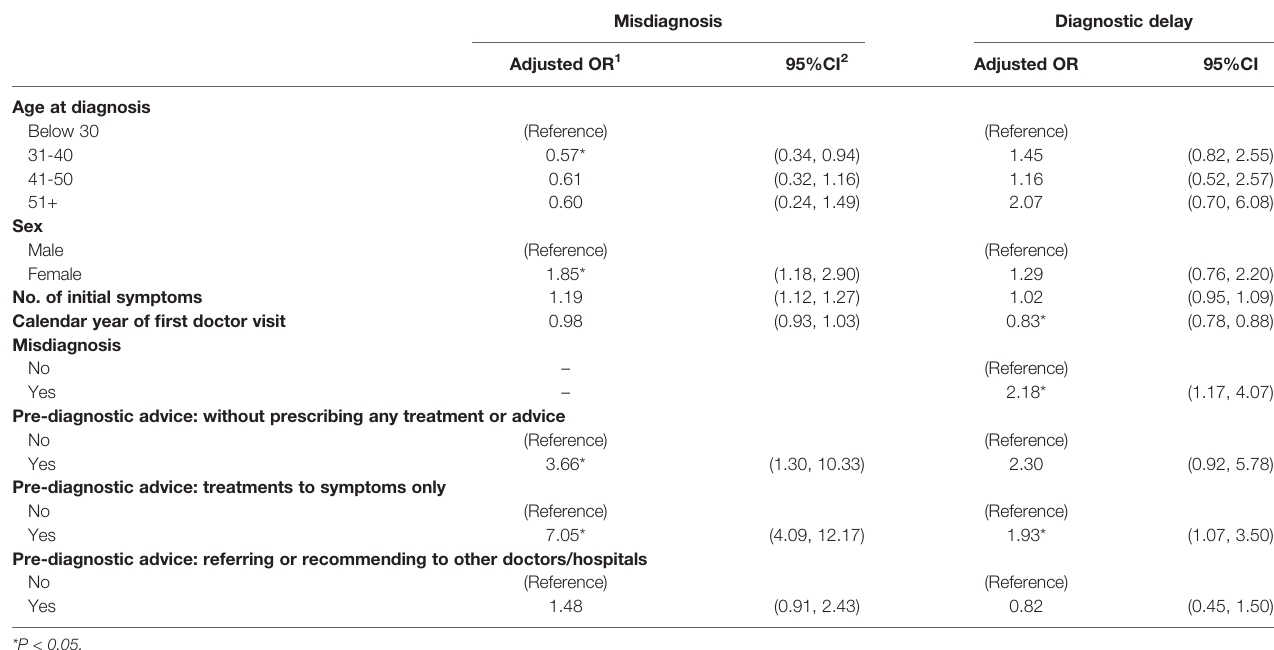
TABLE 2 | Association of experience of misdiagnosis and diagnostic delay with pre-diagnostic advice.